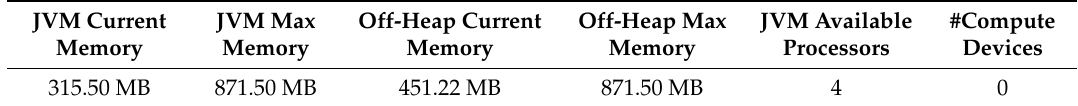
Table 12. Hardware information.